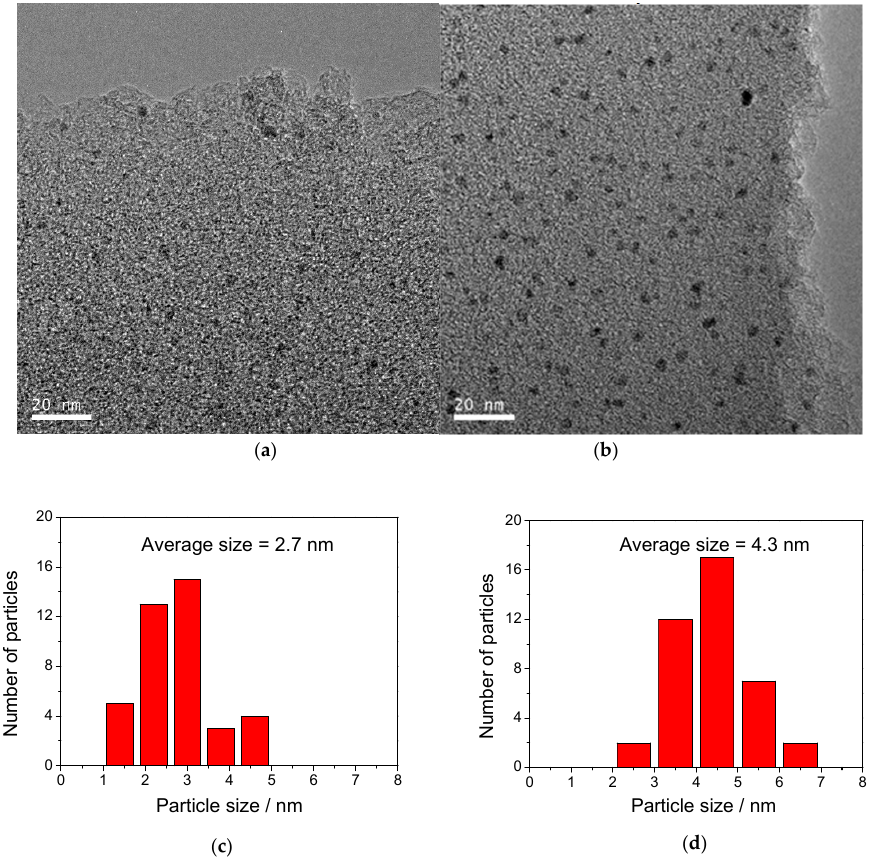
Figure 2. TEM images of ( a ) Pd/AC and ( b ) Pd/N-AC, and Pd size distribution of Pd/AC ( c ) and ( d )